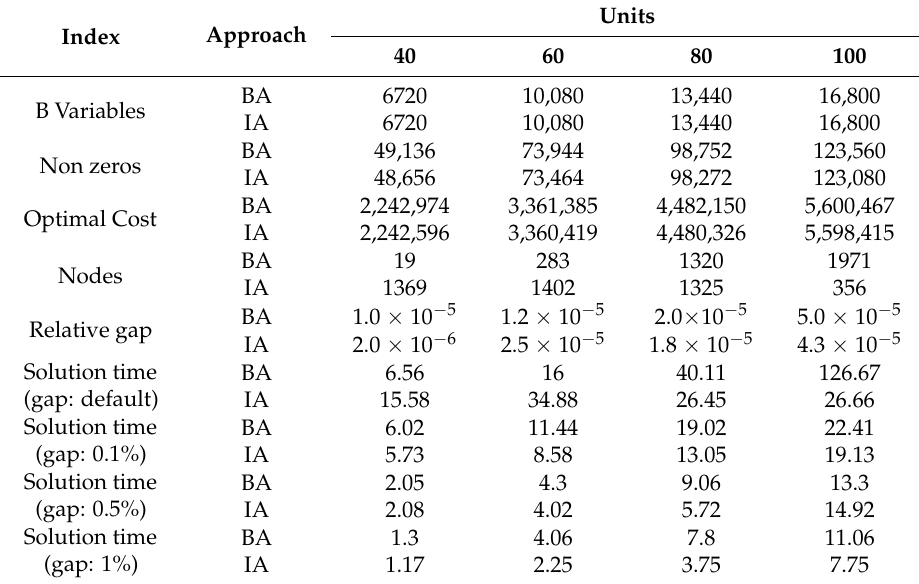
Table 1. Comparison of performance between different hierarchical